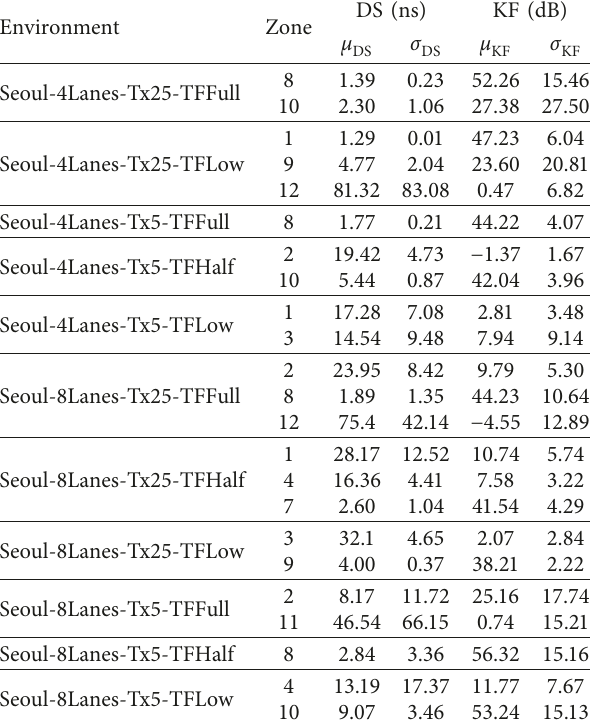
Table 7: Extracted parameters for the PL. Environment